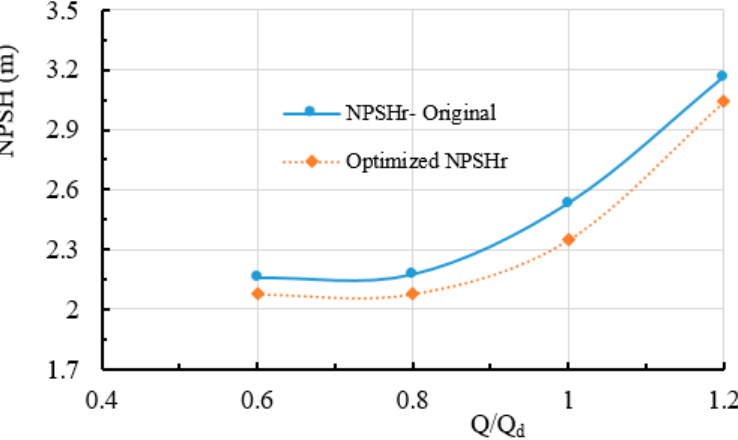
Processes 2019 , 7 , x FOR PEER REVIEW 17 of 24 Figure 16. Predicted NPSHr comparison at di ff erent flow rates. Figure 16. Predicted NPSHr comparison at different flow rates.